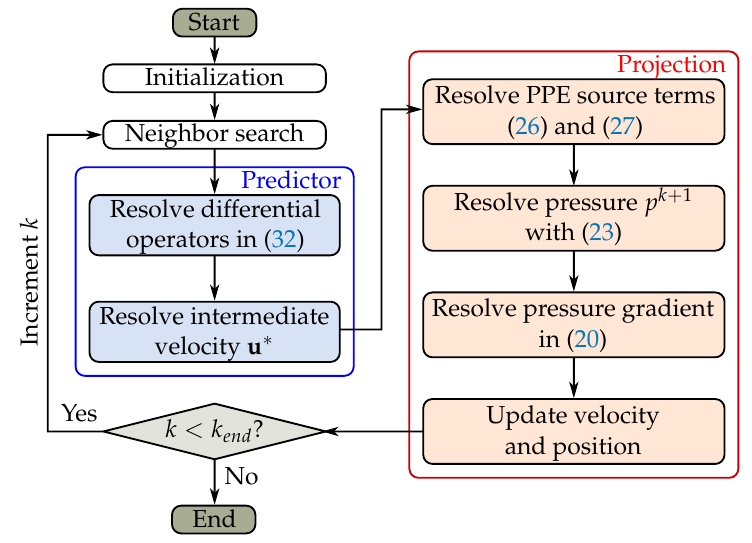
Figure 1. Flow diagram of the numerical scheme.